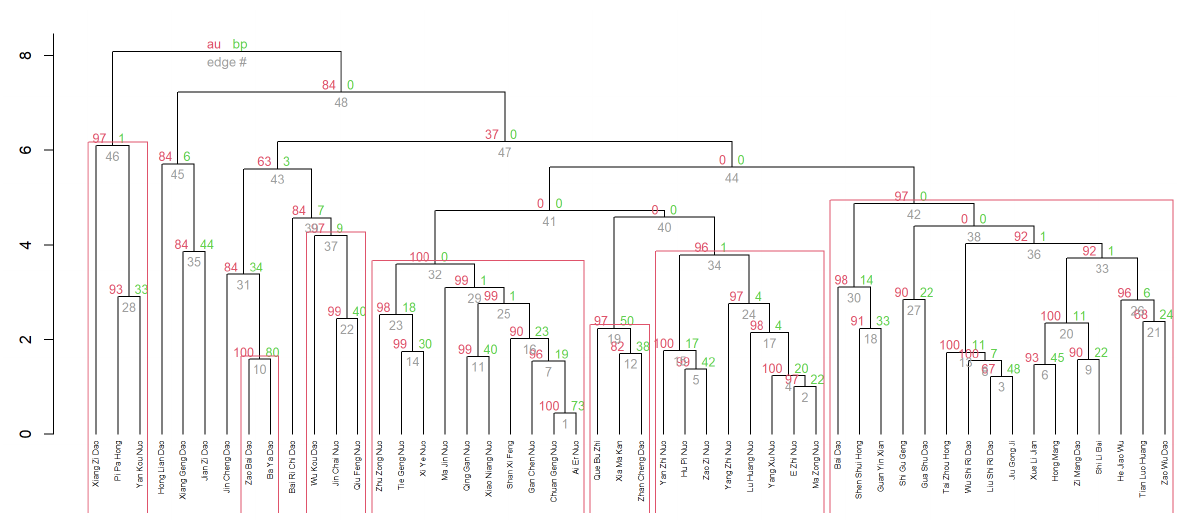
Figure 4. Clustering result in a hierarchical tree structure with marked p -value. AU (approximately unbiased) p -values are in red, BP (bootstrap probability) values are in green, and cluster labels are in grey. Clusters with AU ≥ 95% are framed by the